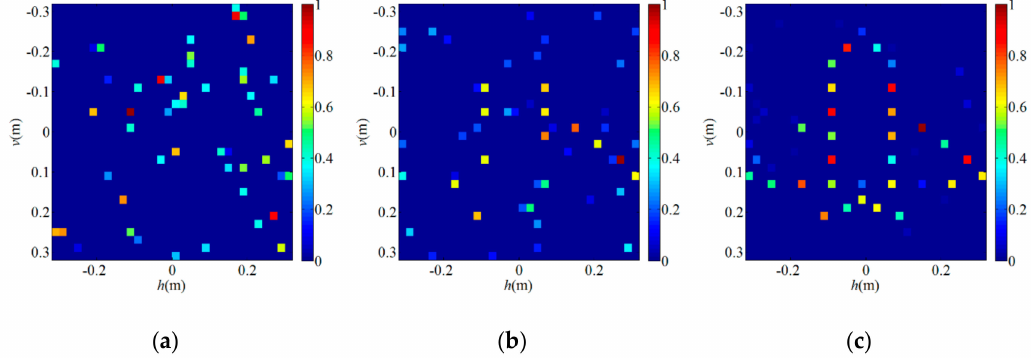
Figure 8. Imaging results of the SWFOS algorithm when L / W = 1.5 in the PL-TCAI system with